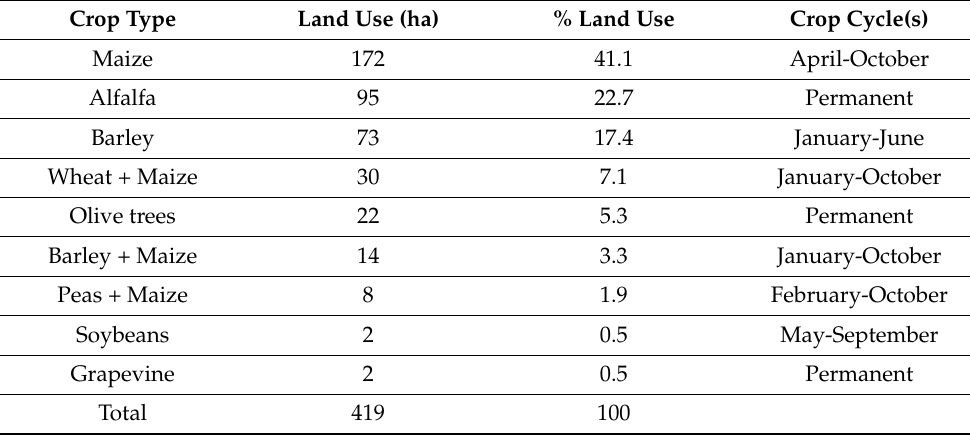
Table 2. AB5 crops during the study period (2019–2020) and its land